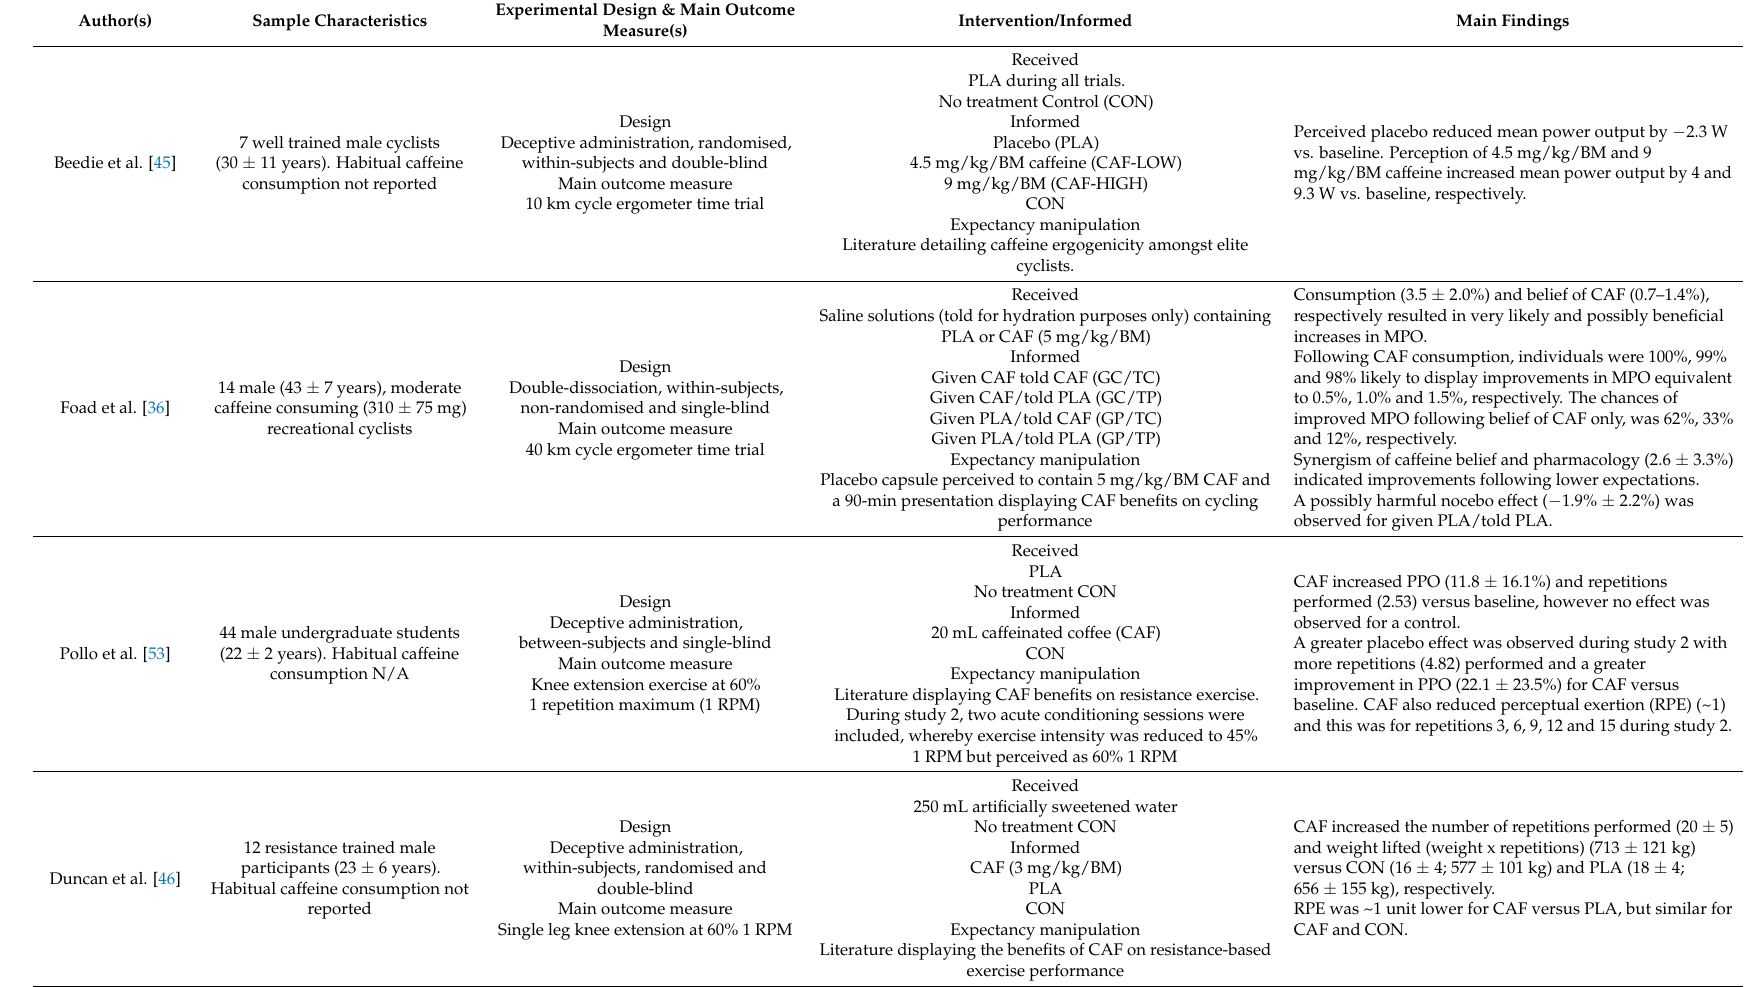
Table 1. Characteristics and findings of studies assessing caffeine expectancies on sport and exercise